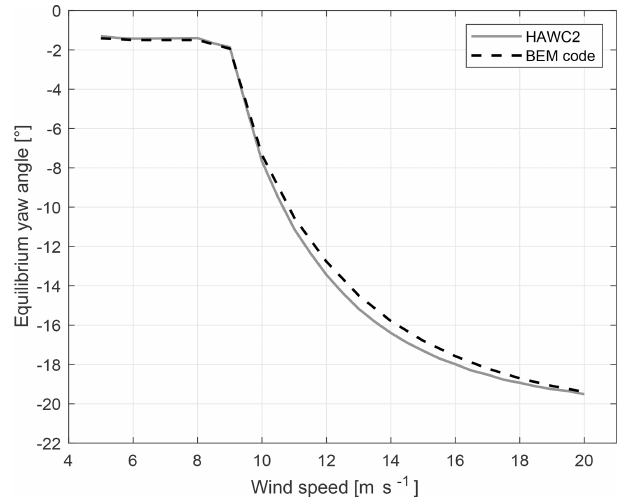
Figure 6. Comparison of the equilibrium yaw angle over wind speed from HAWC2 and the BEM code for the original turbine con- figuration with 5 ◦ tilt and 3.5 ◦